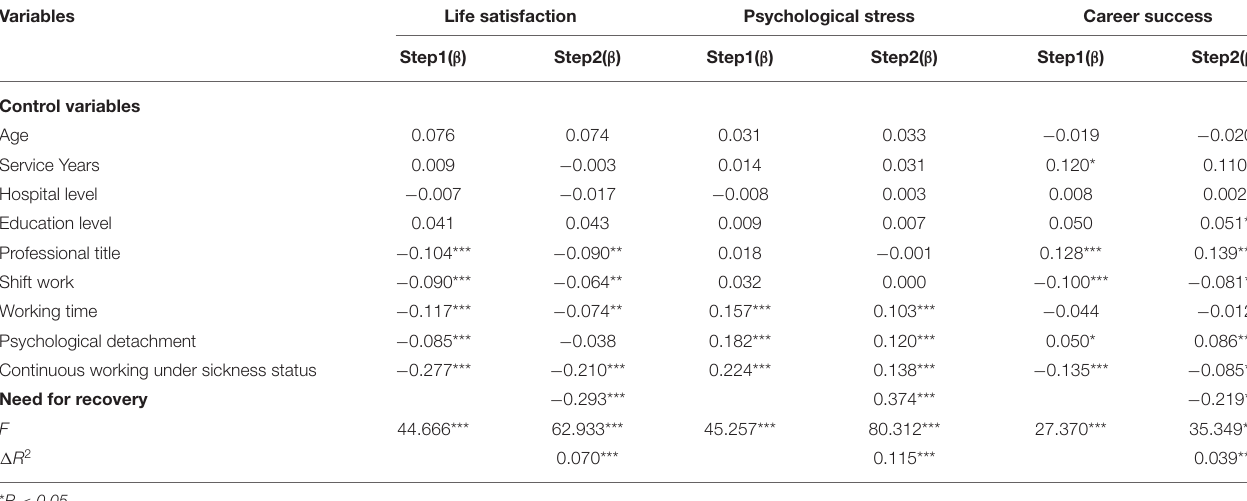
TABLE 4 | Hierarchical linear regression models for workplace well-being.